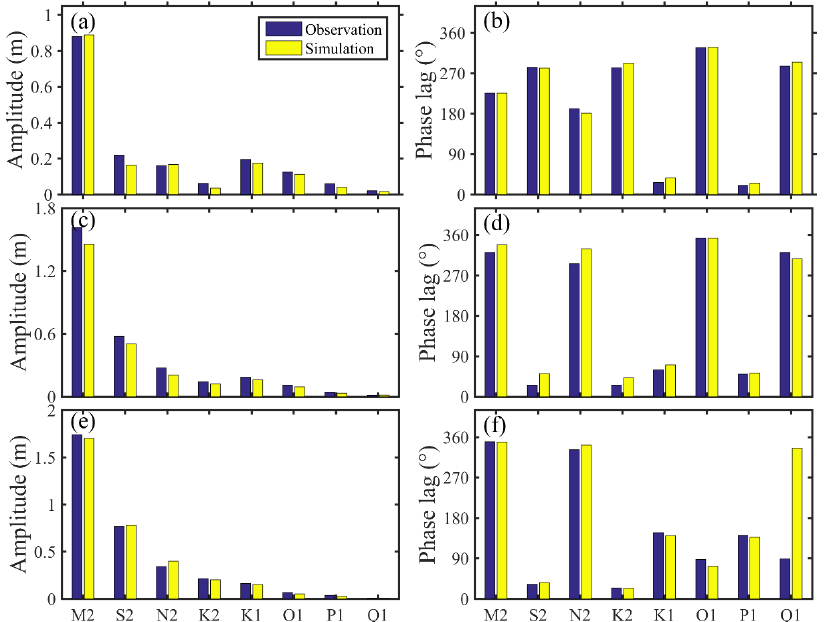
Figure 2. The amplitudes (left panels) and phase lags (right panels) of the eight major tidal constituents from observation (blue) and simulation (yellow) at tidal gauges ( a , b ) Binhai, ( c , d ) Dafeng, and ( e , f ) Lvsi.